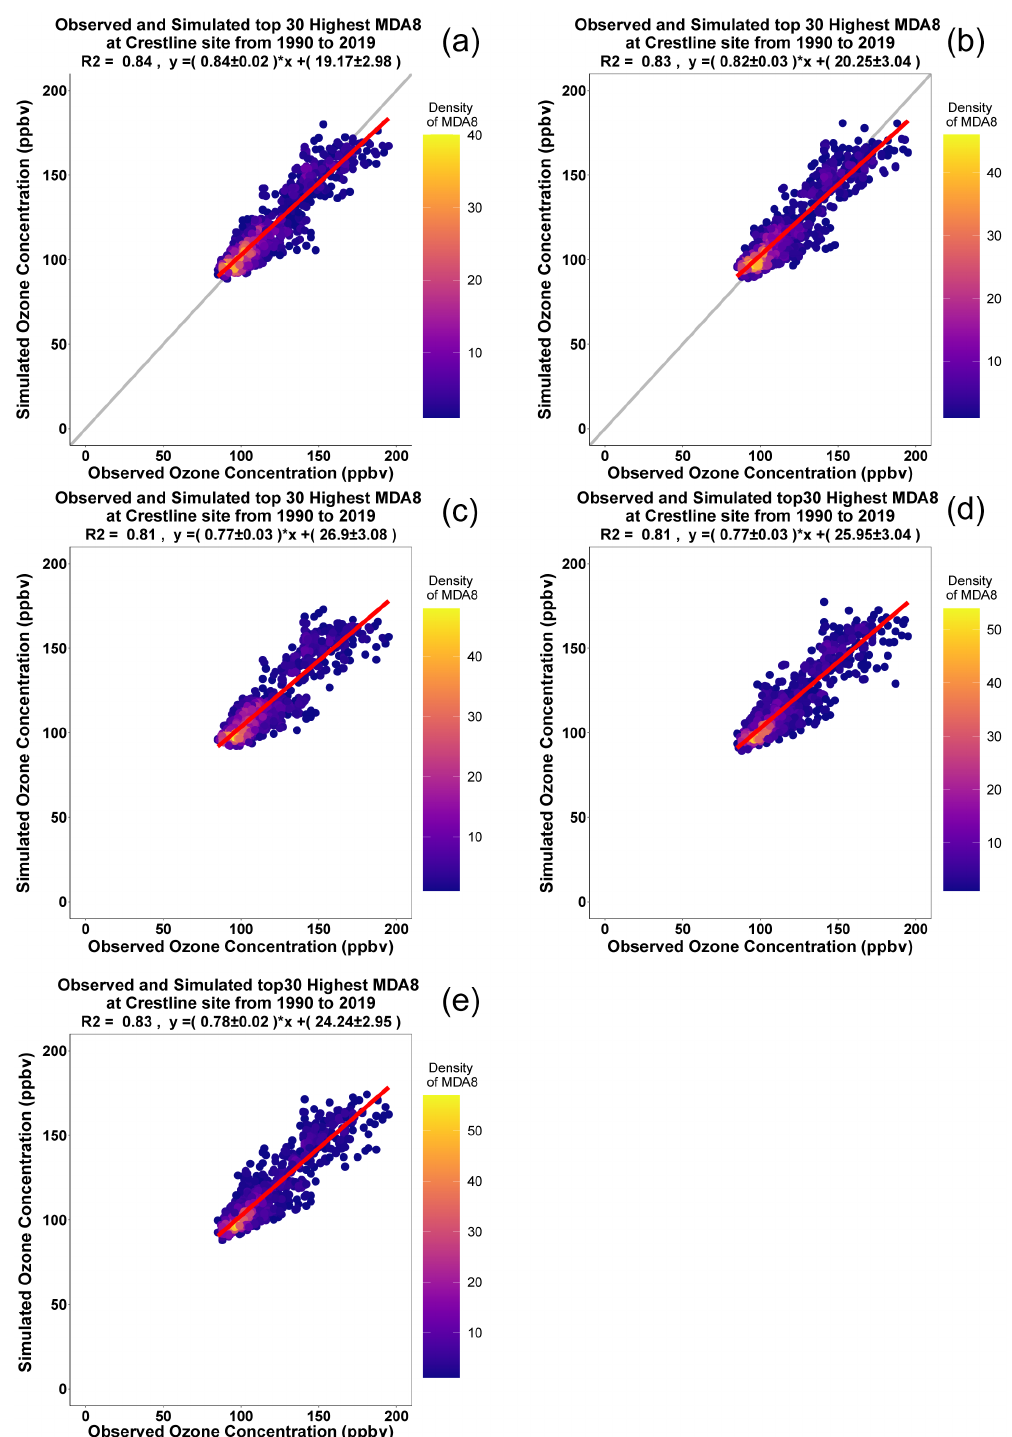
Figure 2. Comparison between the top 30 observed and predicted MDA8 ozone concentrations using the GAM-SoCAB-8HR V1.0 model (a) , MARS-SoCAB-8HR V1.0 model (b) , RF-SoCAB-8HR V1.0 model (c) , SVR-SoCAB-8HR V1.0 model (d) and the SVRoptimal-SoCAB- 8HR V1.0 model (e) .